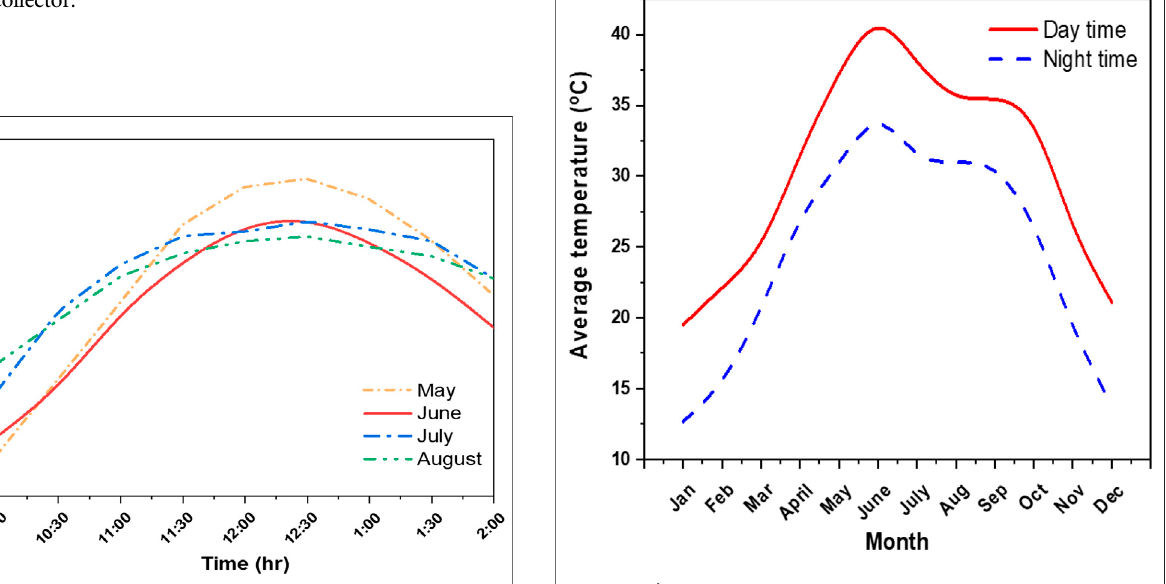
Frontiers in Materials |